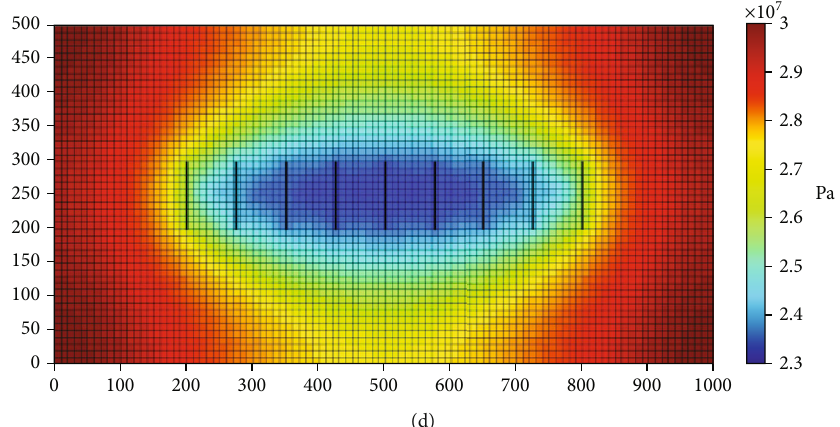
Figure 4: Diagram of meshes, production curve, and pressure distribution: (a) diagram of horizontal well meshes; (b) daily production and accumulative production under di ff erent permeabilities of matrix; (c) pressure distribution when T = 150 d; (d) pressure distribution when T = 210 d.